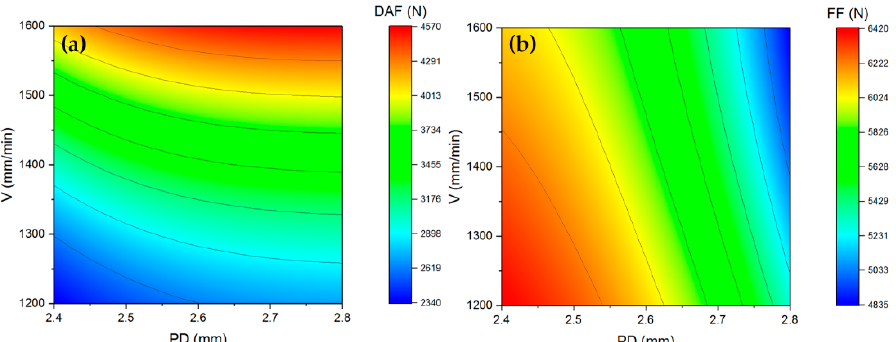
Figure 11. Contour plots of: ( a ) The downward axial force during the RAFSW process; ( b ) Failure force at tensile shear test versus tool plunge depth ( PD ) and welding traverse speed ( V) , while other geometry and process parameters are the same as parameters of sample No. 21 except for the plunge depth, which is the same as pin length. The contour plots were extracted from developed ANN models in this paper.